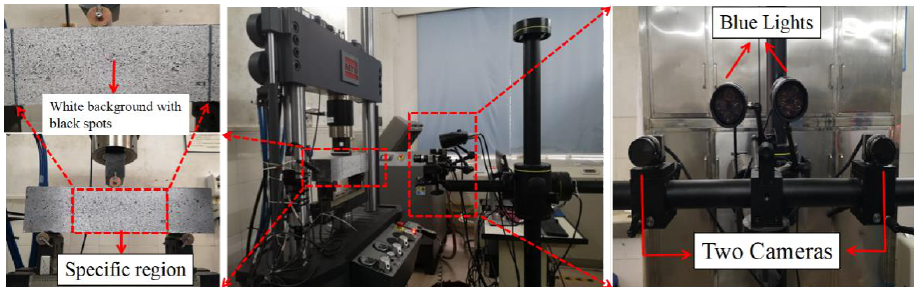
Figure 3. Test configuration of the DIC technique.